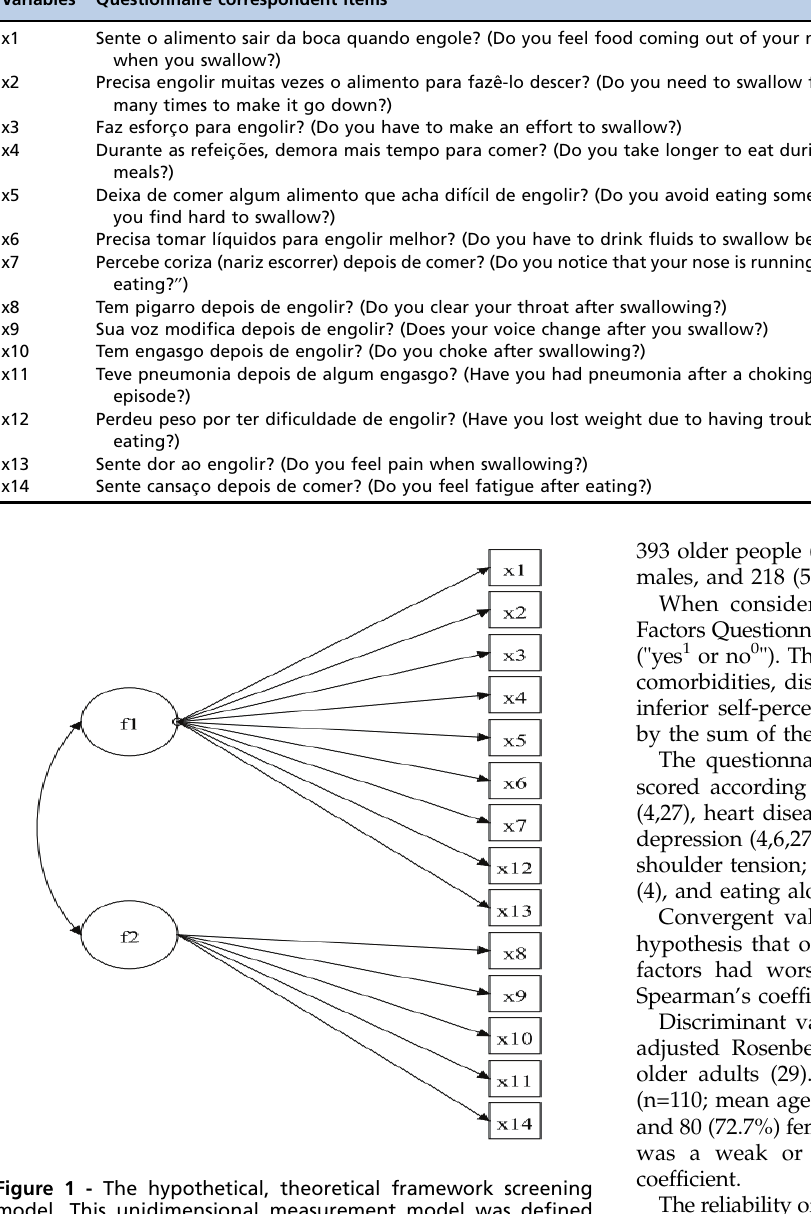
Table 2 - Categorization of items according to outcomes of deglutition disorders based on the literature. Variables Questionnaire correspondent items